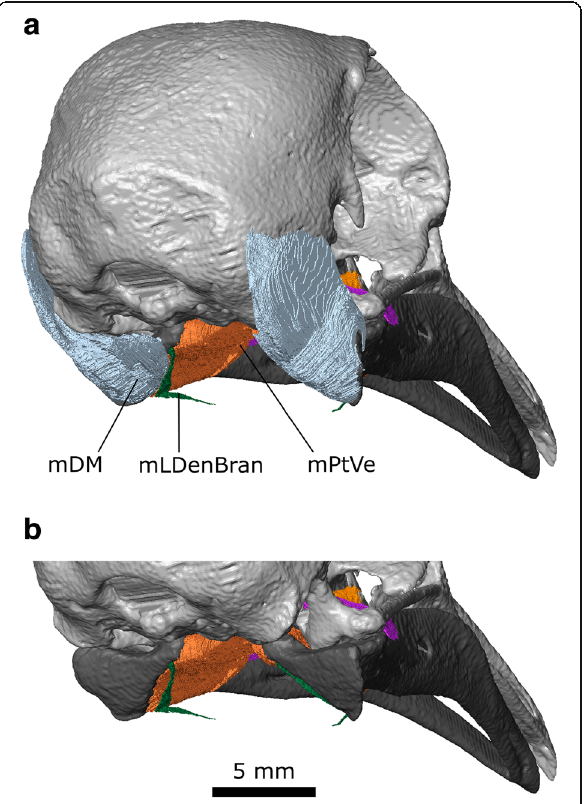
Fig. 11 The depressor mandibulae of Columba livia in posterior